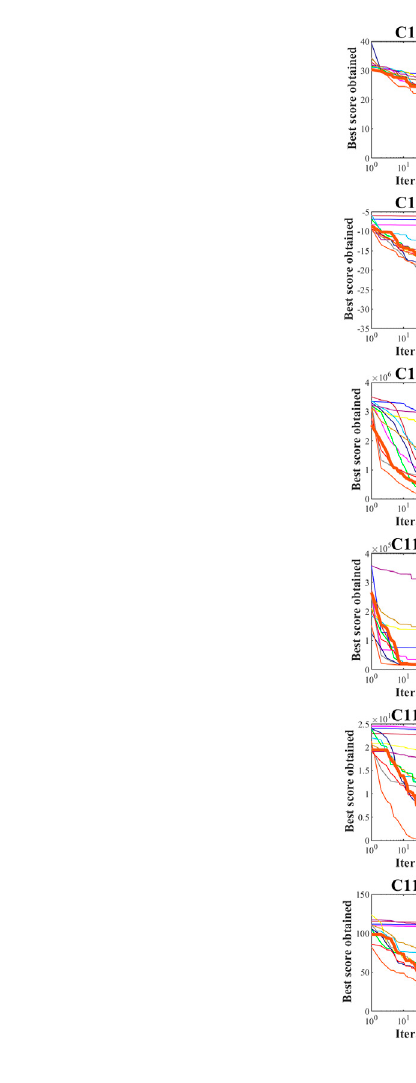
FIGURE 7 Boxplot of OOA and competitor algorithms in optimization of the CEC-2011 test